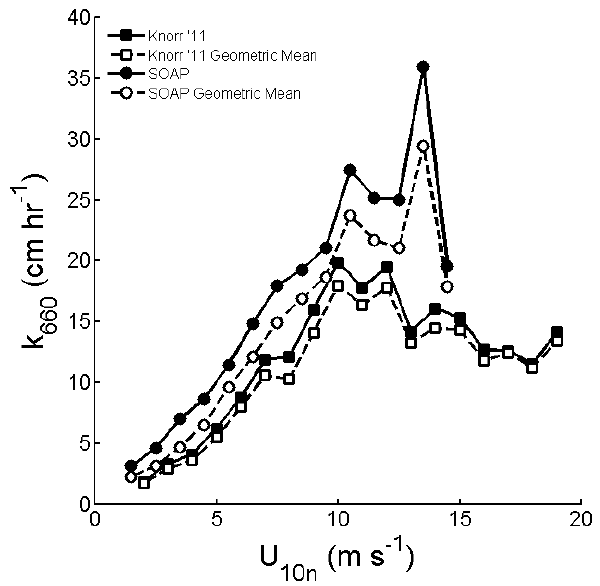
Figure 4. Bin average gas transfer coefficients for this study (SOAP) and the data collected in the North Atlantic ( Knorr ’11). Mean values were calculated for 1ms − 1 U 10 n bins using arithmetic (solid lines, filled symbols) and geometric (dashed lines, open sym- bols)